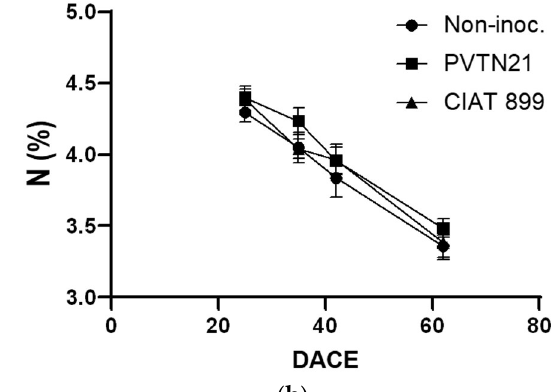
Table 1. Impact of different inorganic-N fertigation schemes and rhizobia inoculants on the growth and nodulation capacity of the common bean ( Phaseolus vulgaris L.).